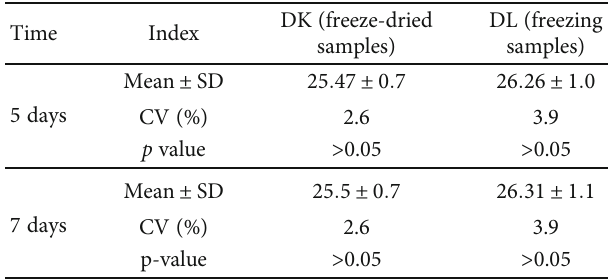
Table 5: Stability of the serum samples at 30 °